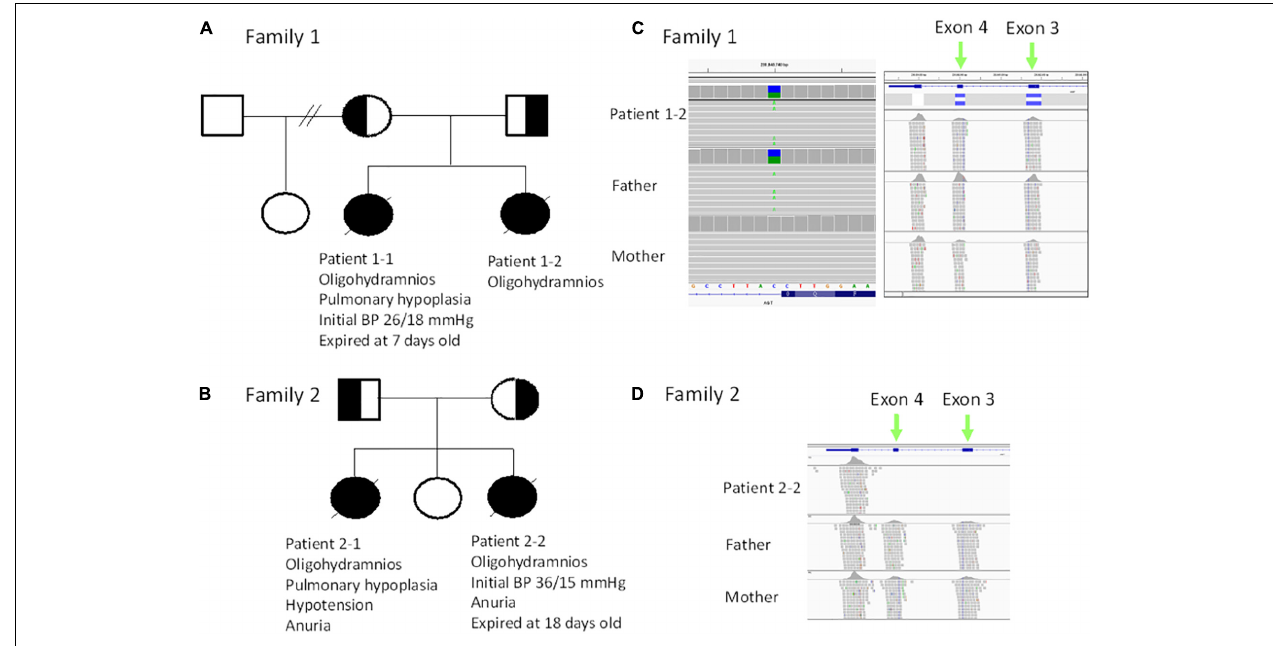
FIGURE 1 | (A) Pedigree of family 1. (B) Pedigree of family 2. (C) Trio exome sequencing revealed a heterozygous c.856 + 1G > T mutation (in the reference is C, alteration is A) patient 1–2 and the father (left panel), while a heterozygous deletion (blue bar) in exon 3 and exon 4 was noted in patient 1–2 and mother. (D)